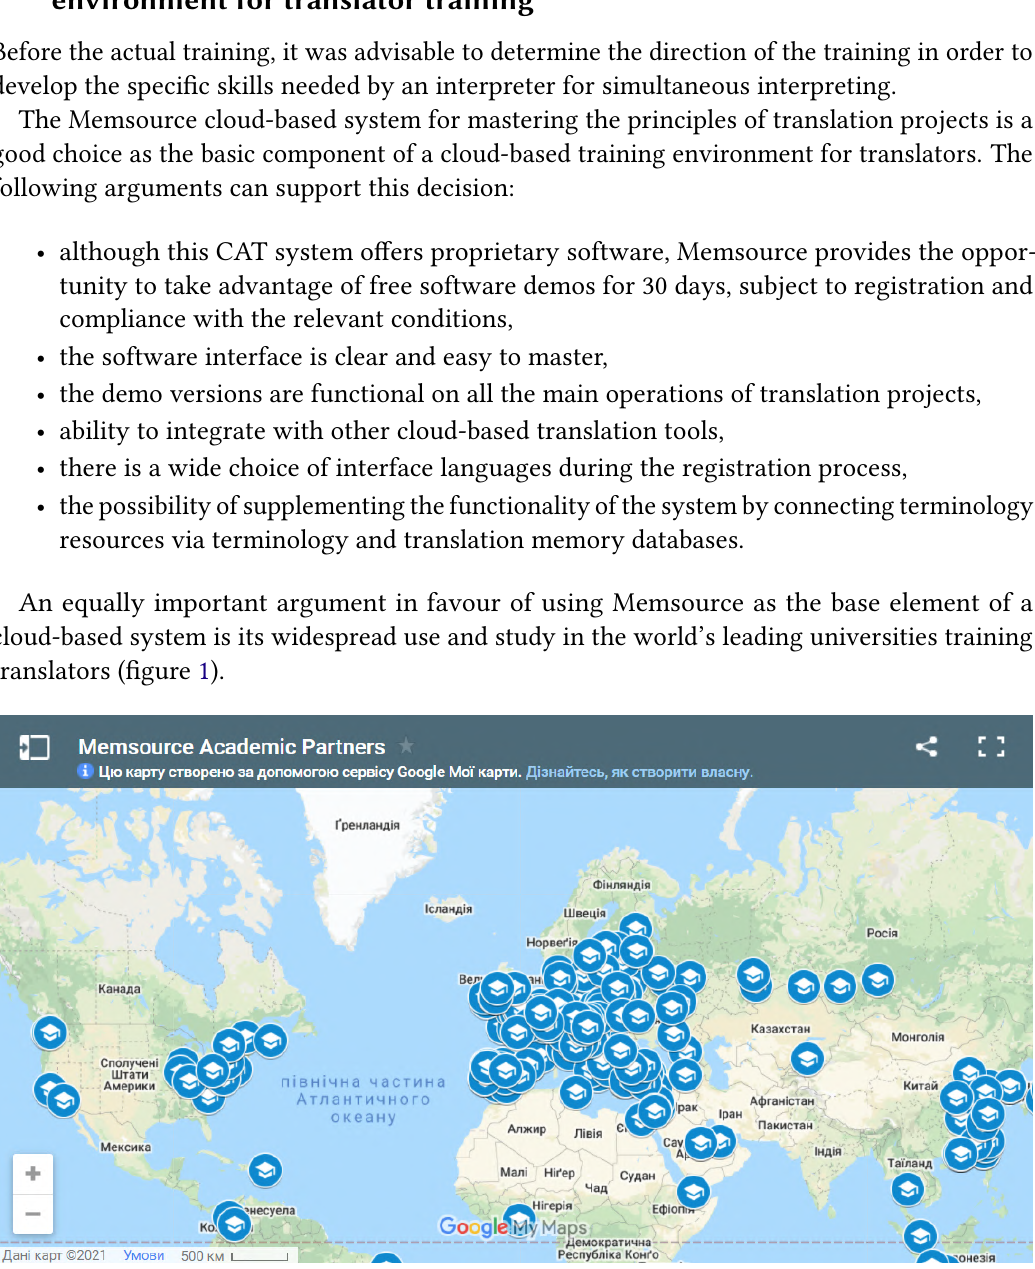
Figure 1: Geography of university use of the Memsource cloud